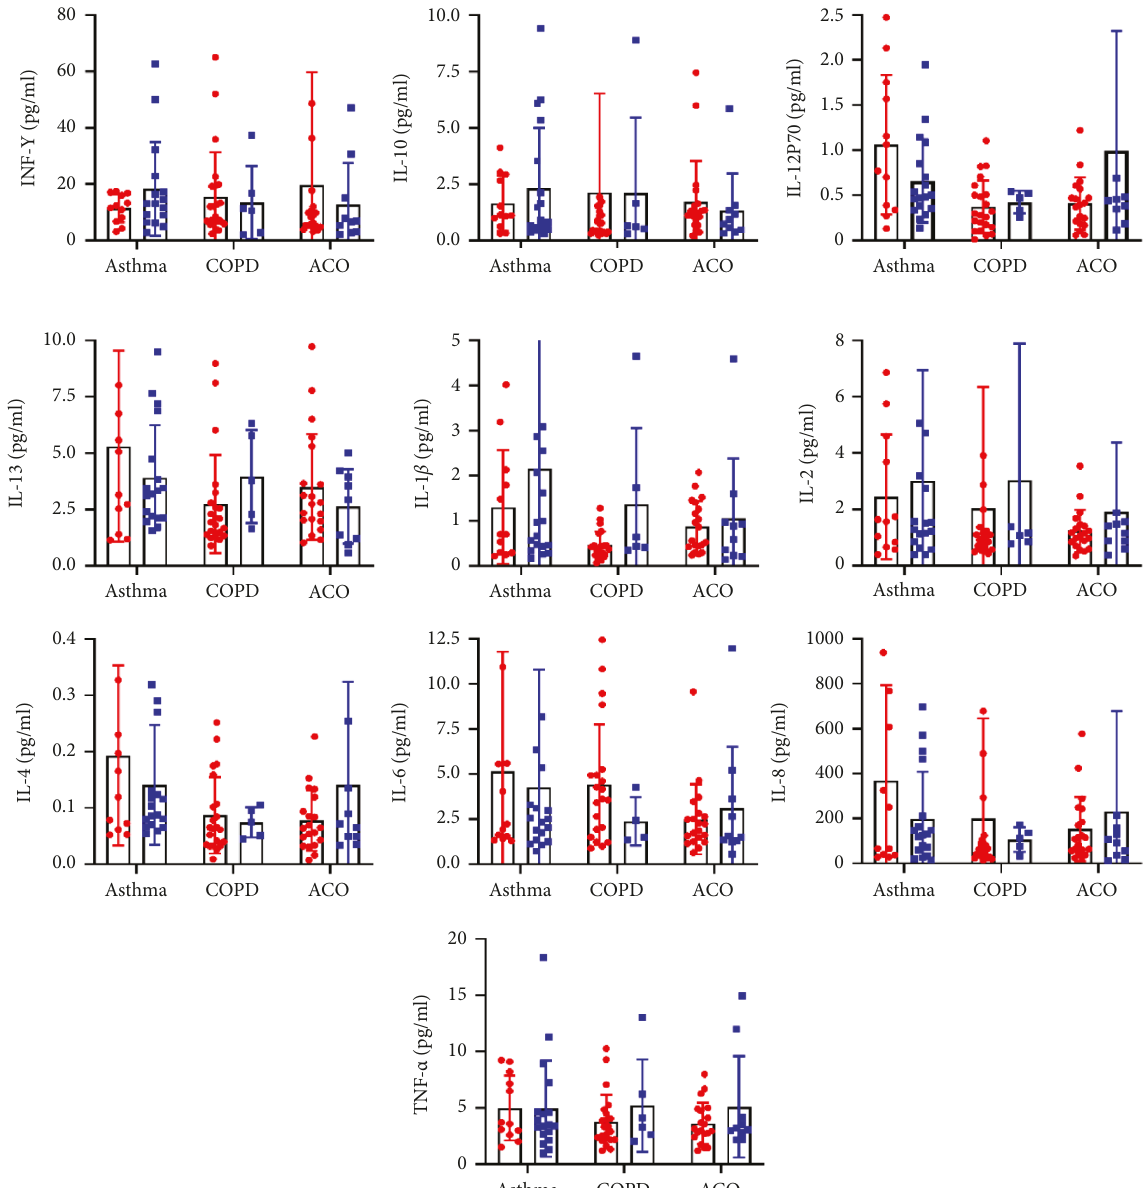
Figure 7: The levels of ten cytokines in the three diseases at different eosinophil levels. Red: eosinophil levels < 0.3 (10 9 /L), Blue: eosinophil levels ≧ 0.3 (10 9 /L). All data are mean ± SD of 6 to 24 samples from each group. ∗ p < 0 . 05. (COPD, chronic obstructive pulmonary disease; ACO, asthma-COPD overlap; SD: standard